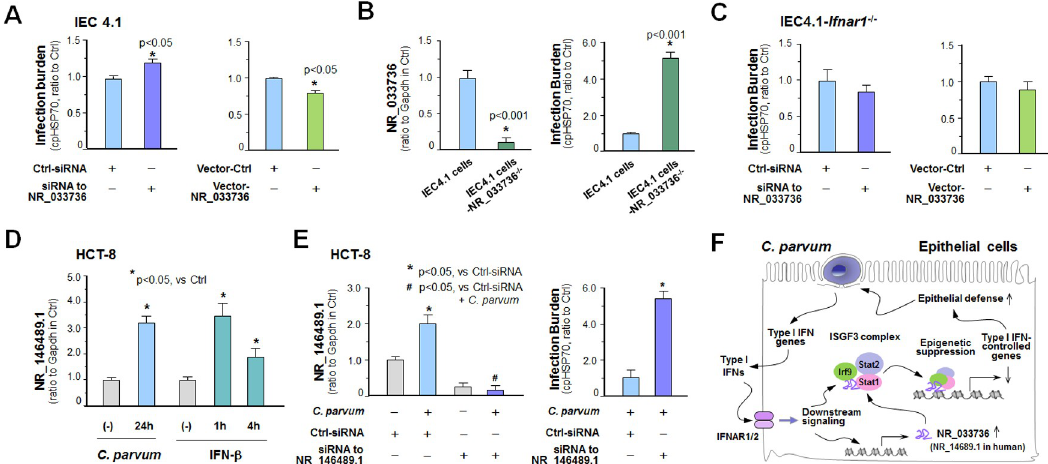
Fig 7. NR_033736 and its putative human ortholog modulate intestinal epithelial defense against C . parvum infection. (A) Effects of NR_033736 expression on the infection burden of C . parvum in IEC4.1 cells. Cells were treated with the siRNA to NR_033736 or transfected with the vector expressing NR_033736 (Vector-NR_033736) for 24 h and exposed to C . parvum infection for 24 h. Cells treated with the Ctr-siRNA were used as the control. Infection burden was quantified by measuring parasite cpHsp70 using qRT-PCR. (B) Knockout of NR_033736 via the CRISPR/Cas9 approach on C . parvum infection in IEC4.1 cells. IEC4.1 cells stably deficient in NR_033736 were generated via the CRISPR/Cas9 approach and verified by using qRT-PCR. Cells were exposed to C . parvum sporozoites for 24h and infection burden was quantified. (C) Effects of NR_033736 expression on the infection burden in IEC4.1 cells with deficient in Ifnar1 . IEC4.1- Ifnar1 -/- c ells were treated with the siRNA to NR_033736 or transfected with the Vector- NR_033736 for 24 h and exposed to C . parvum infection for 24 h. Infection burden was quantified. (D) Upregulation of NR_146489.1 in cultured human intestinal epithelial cells (HCT-8) following C . parvum infection or IFN- β stimulation. HCT-8 cells were exposed to C . parvum infection for 24 h or treated with IFN- β for up to 4 h and expression level of NR_146489.1 was validated by using qRT-PCR. (E) Knockdown of NR_146489.1 increased the infection burden of C . parvum in HCT-8 cells. Cells were treated with the siRNA to NR_146489.1 for 24 h and exposed to C . parvum infection for additional 24 h. Cells treated with the non-specific scrambled siRNA were used as the control. Expression levels of NR_146489.1 and infection burden of C . parvum were